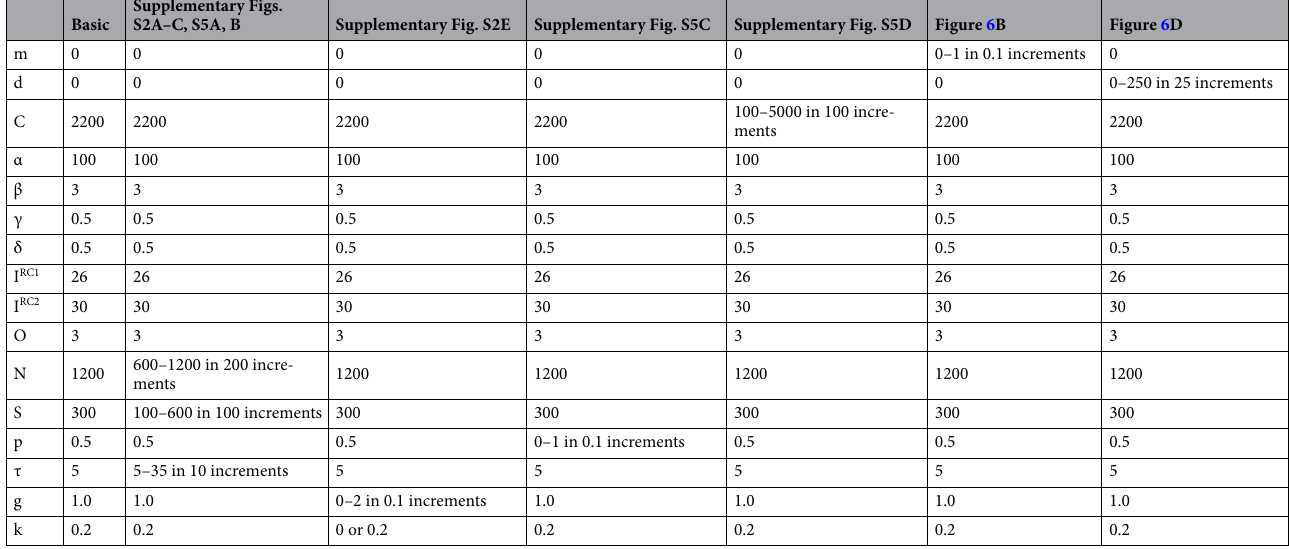
Table 1. A list of model parameters used in the validation. Parameters used in simulations are as follows: m, d , and C are parameters related to the input signal, where m is the non-coincidence rate of the input stimulus, d is the delay time, and C is the total number of stimuli, including random sequences. α, β, γ , and δ are parameters involved in the learning of the network. α plays a role in the learning rate in FORCE learning. β , γ , and δ are constants. For more information on α , see Sussillo 40 . I RC1 , I RC2 , O, N , and S are the parameters that make up an RC. I RC1 and I RC2 are the numbers of input nodes, O is the number of read nodes, N is the number of reservoir nodes, and S is the number of reservoir nodes coupled to the read nodes of RC1 and RC2. p, τ, g , and k are the parameters that control the dynamics of the reservoir neurons. p is the connection probability of reservoir neurons, τ is the time constant that determines the dynamics of the reservoir neurons, g is the parameter that controls the dynamics, and k is the rate at which noise is